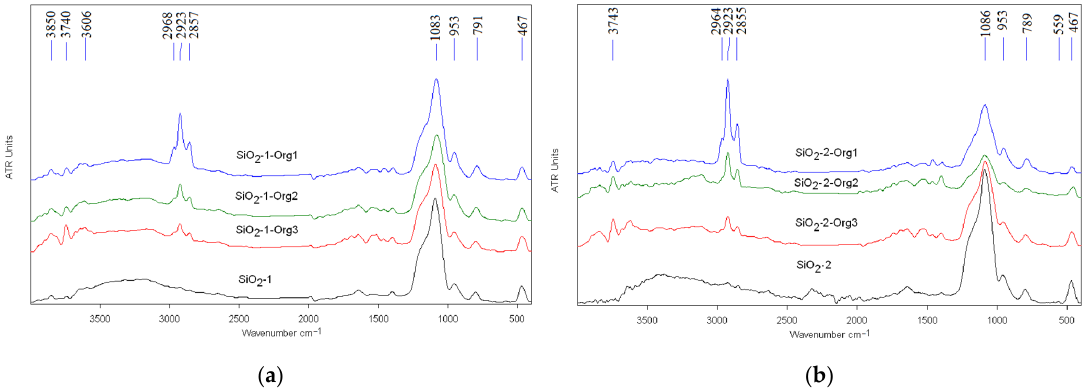
Figure 3. FTIR spectra for pure silica and organically modified silica obtained at various EtOH:water:NH 4 OH molar ratio: Series TEOS:NH 4 OH:H 2 O = 1:3.4:15.2 ( a ); Series TEOS:NH 4 OH:H 2 O = 1:12.7:57.3 ( b ).